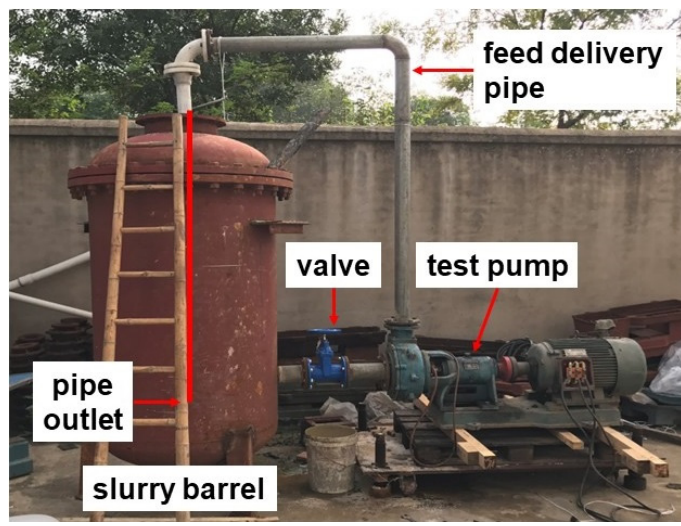
Figure 6. Wear test rig.